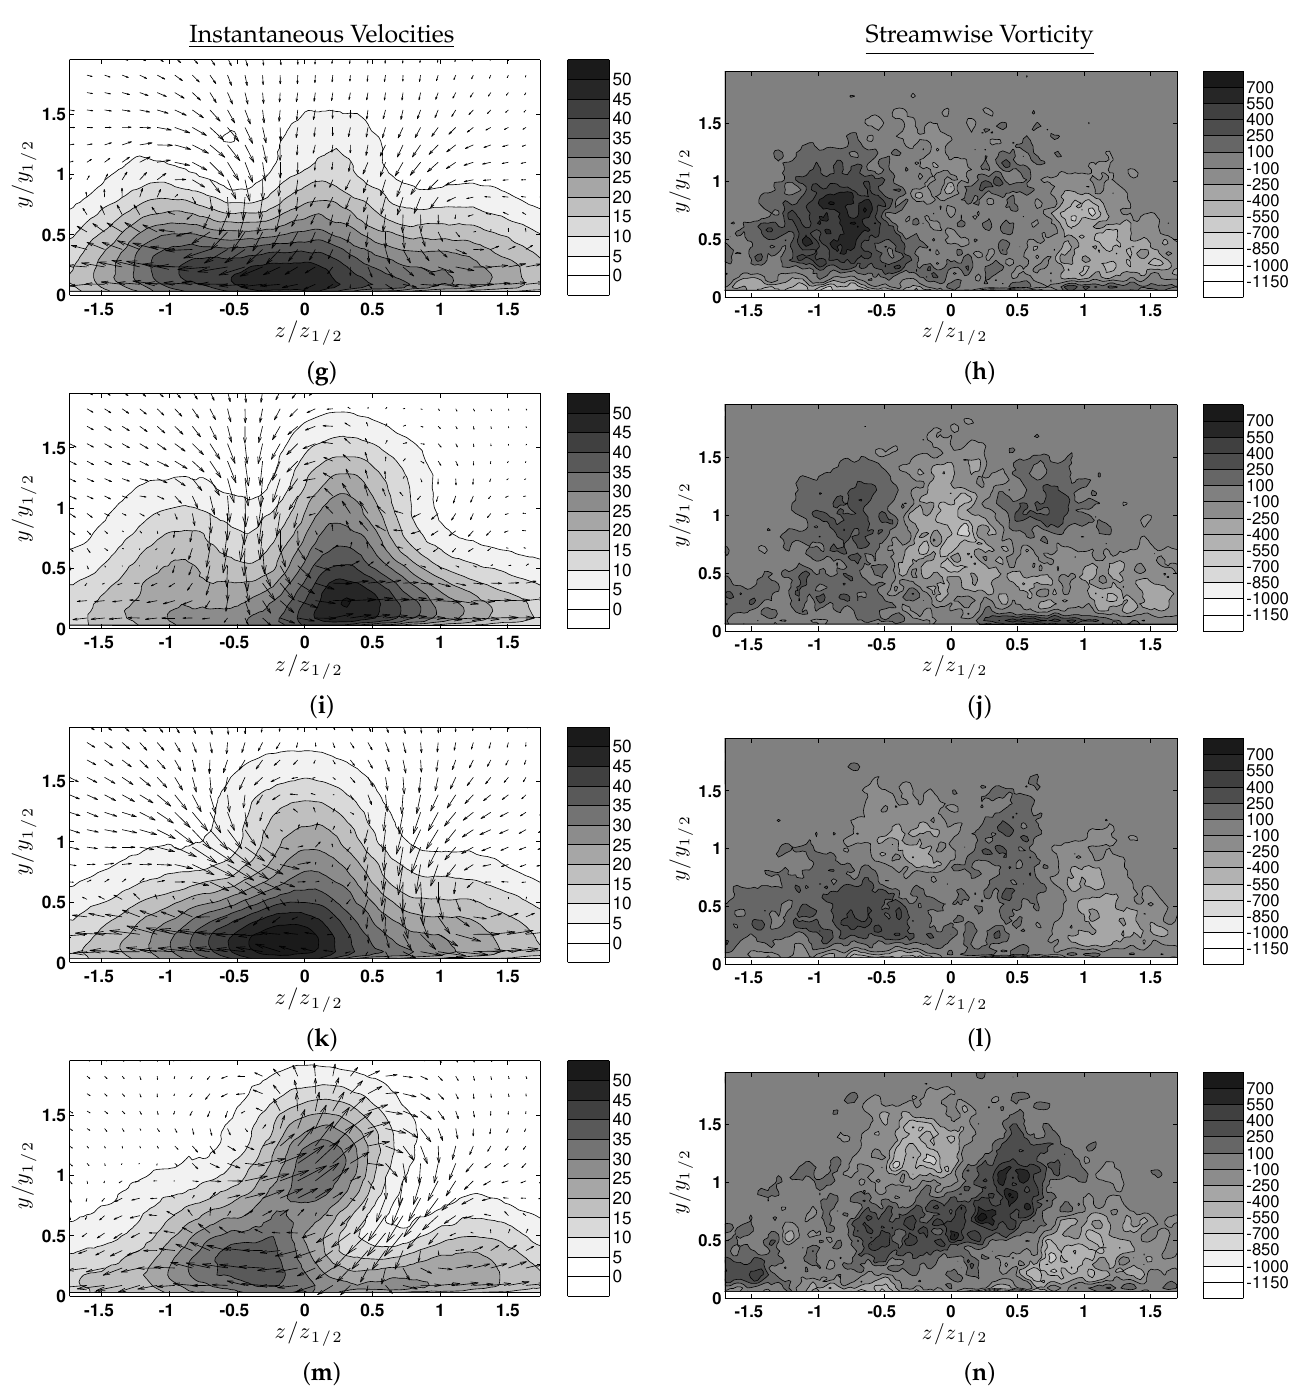
Figure 8. POD reconstruction of the instantaneous velocity ( m / s ) using the first 10 modes and the reconstructed instanta- neous streamwise vorticity ( 1/ s ) at x / D = 20. The mean streamwise velocity (normalized) and mean streamwise vorticity are shown in the first